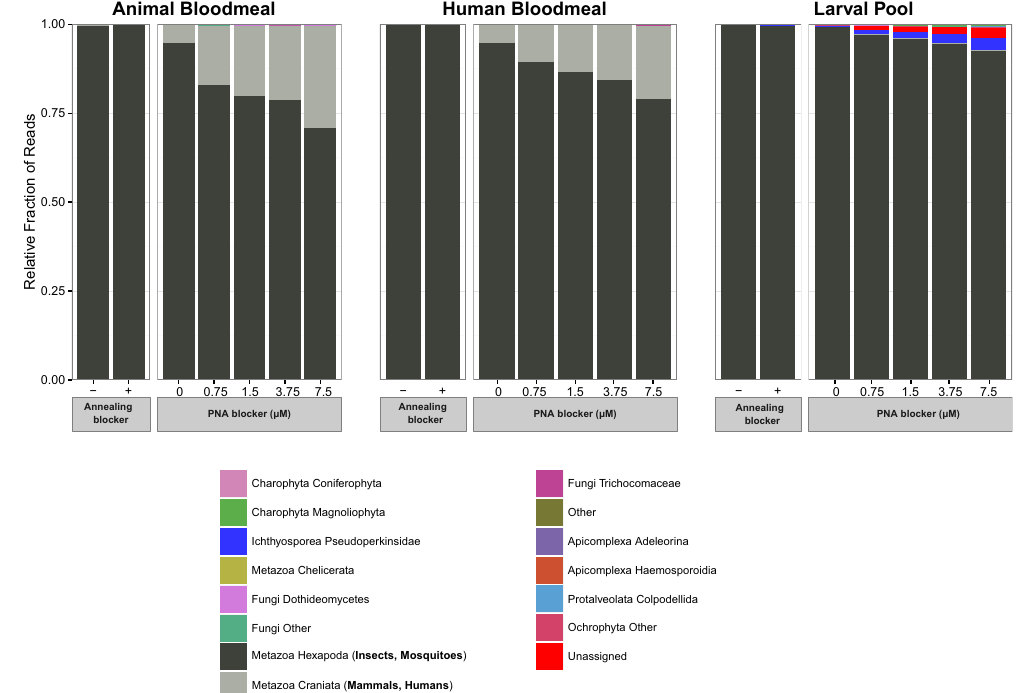
Figure 4. Taxonomic profile of 18s rRNA gene amplicons for the V9 hypervariable region generated under different blocking conditions. Mammalian and mosquito hits are shown in grey scale while those of eukaryotic microbes are shown in colour. In all three samples, use of the mosquito specific PNA blocker decreased mosquito reads, though to a lesser extent than with the V4 PNA blocker (compare to Fig. 3). Sequences were collapsed at the V6 level of Silva 119 eukaryotic taxonomy, and lineages with less than 100 total amplicons were collapsed into the Other class to facilitate legend visualization.